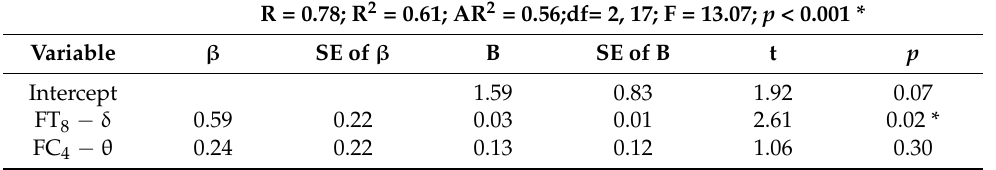
Table 12. Regression analysis for the low/high frequency heart rate variability ratio and electroen- cephalography variables in train